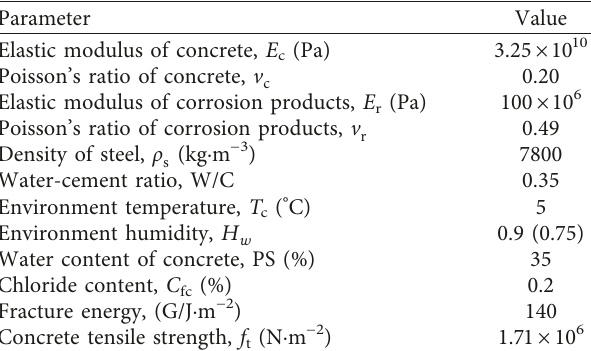
Figure 4: Corrosion-induced crack pattern of concrete in (a) Ozbolt’s experiment and (b) our model’s simulation. Table 1: Material parameters